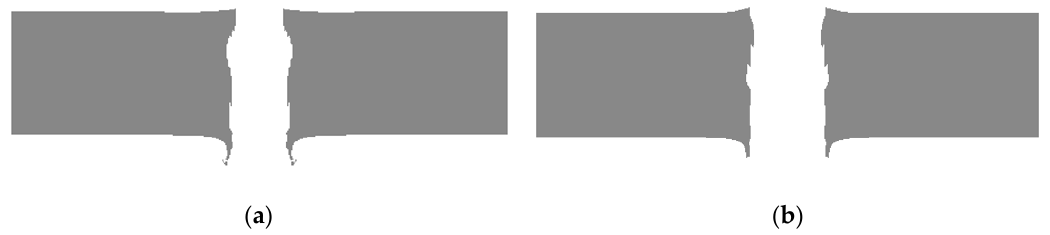
Figure 11. Damage effects of projectiles on RHA target plates: ( a ) Standard projectile; ( b ) ceramic composite projectile (Ø5 mm).